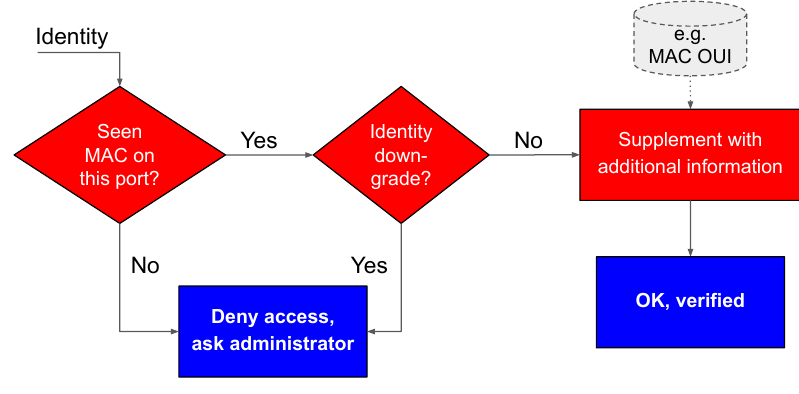
Figure 5. Verifying identity files submitted by IoT